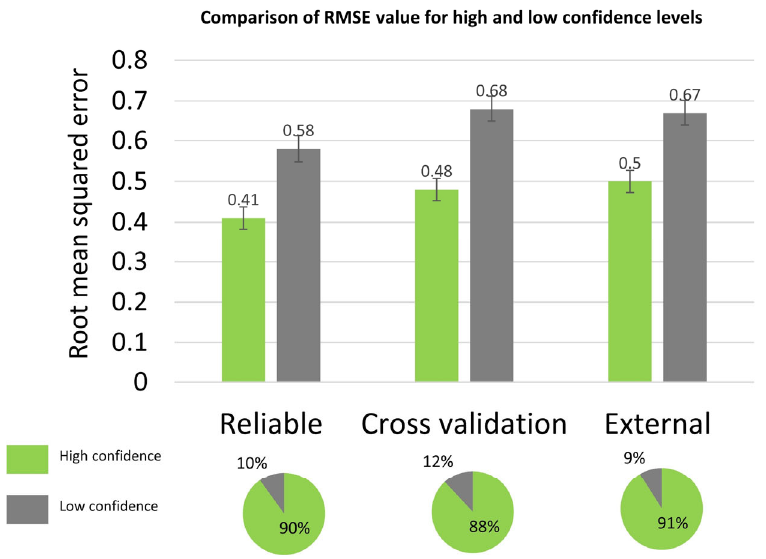
Figure 3. Comparison of the error metrics for high and low confidence levels. RMSE: root mean squared error. For each validation set, the pie chart shows the proportion of high and low confidence samples.